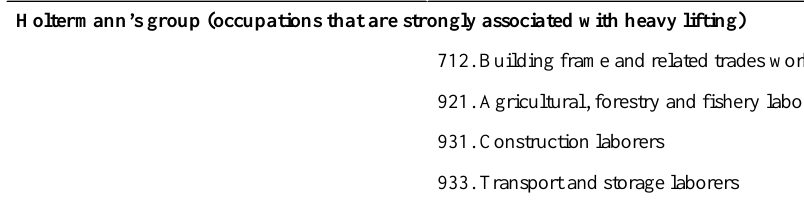
Other blue-collar workers (occupations in which heavy lifting is less likely to occur)